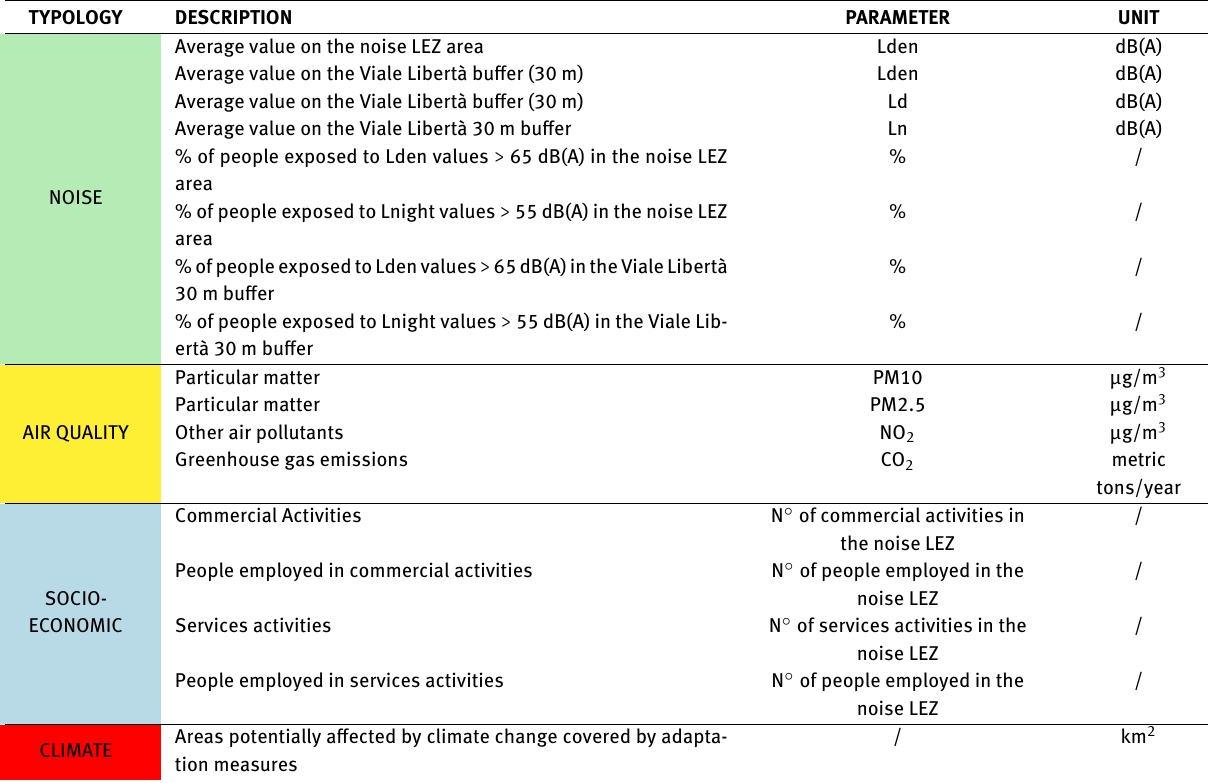
Table 1: Noise, air quality, socio-economic, climate parameters selected for the GI.